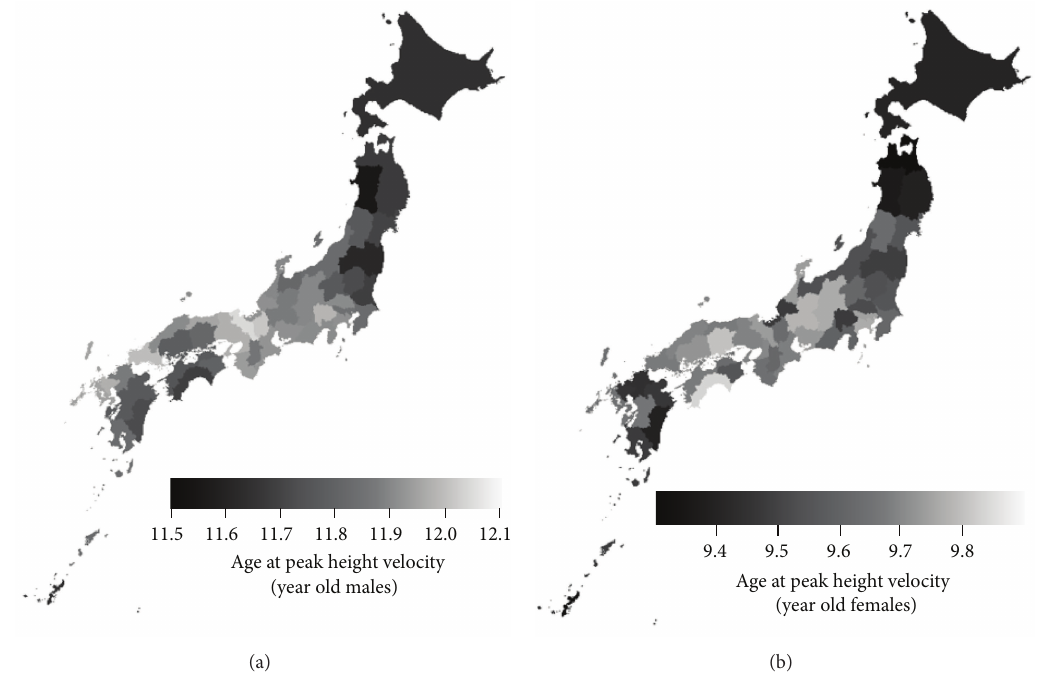
Figure 4: Distribution map of age at PHV in Japanese children. Distribution map of the 8-year (2006–2013) averages of the age at PHV in (a) 5-year-old males and (b) 5-year-old females in each prefecture. The age at PHV tends to be earlier in the northern areas and Okinawa prefecture for both